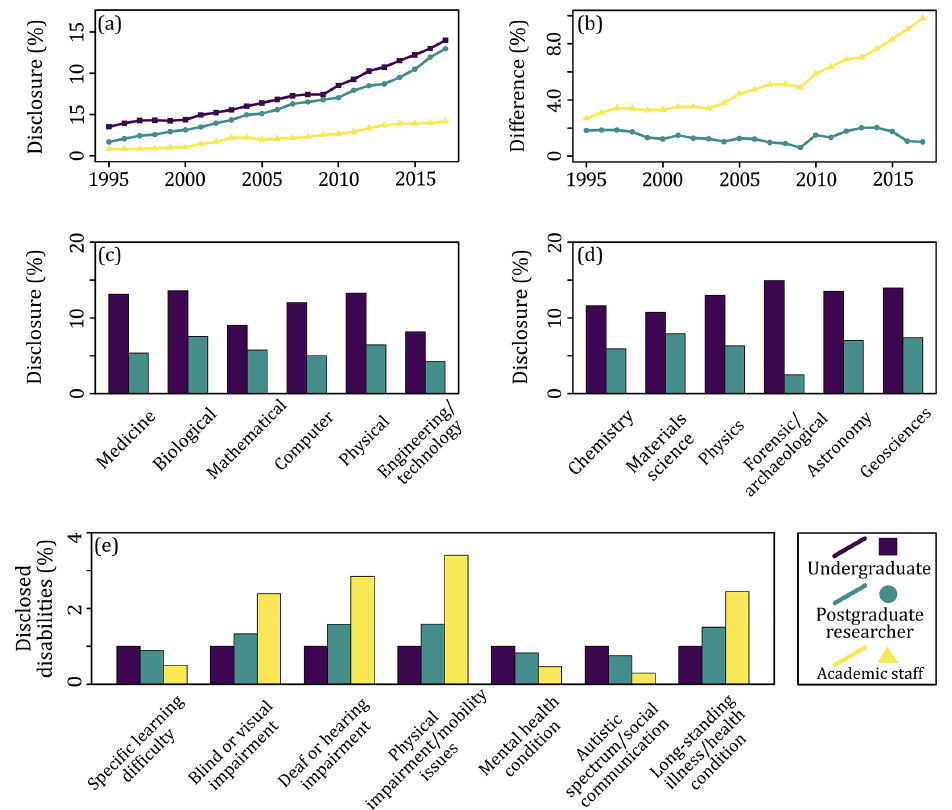
Figure 1. Disability disclosure within higher education. (a) The percentage of individuals who disclosed a disability increased between 1995 and 2017. (b) The difference in the percentage of undergraduate and postgraduate students who disclosed a disability remained relatively constant since 1995, with around 1.5% more undergraduates disclosing a disability compared to postgraduates. However, the difference in the percentage of undergraduate students and academic staff who disclose a disability has increased almost every year; a much greater proportion of undergraduate students report a disability compared to academic staff. Students who complete their undergraduate science (c) or physical science (d) studies are approximately twice as likely as postgraduate students to disclose a disability, although there is discrepancy between disciplines. Disclosure rates are averaged for four academic years, 2014–2015 to 2017–2018. (e) The type of disclosed disability varies between groups, with autistic spectrum conditions being particularly underrepresented within postgraduate research students and academic staff. Data are averages between 2014–2015 and 2017–2018, and results are normalized against undergraduate results. Data from HESA (2019a,